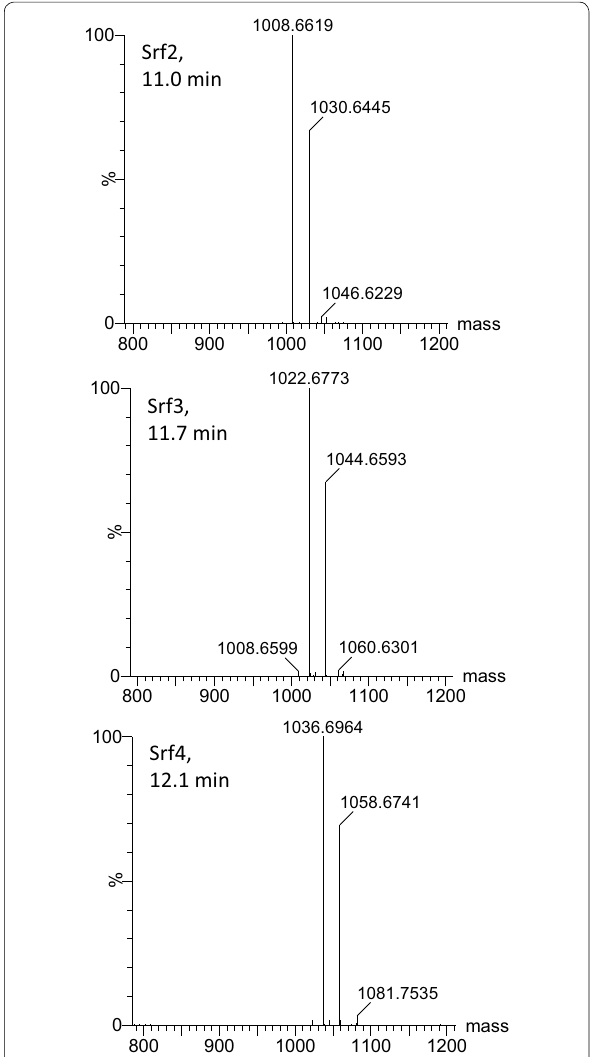
Fig. 3 Examples of the ESI–MS mass spectra of three major surfactin groups detected with UPLC–MS. The positive mass spectrum gener- ated with MaxEnt 3 is shown. The indicated masses are [ M r values of singly charged species. Refer to Table 3 for identities of Srf1-5 and expected m/z and M r